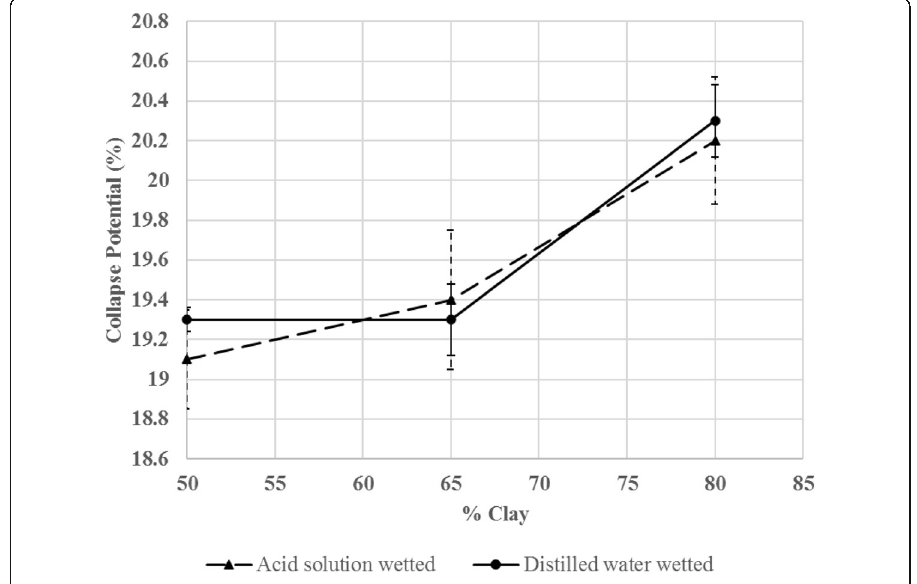
Fig. 9 Effect of clay content on the CP of silty-clay soils with different wetting fluids